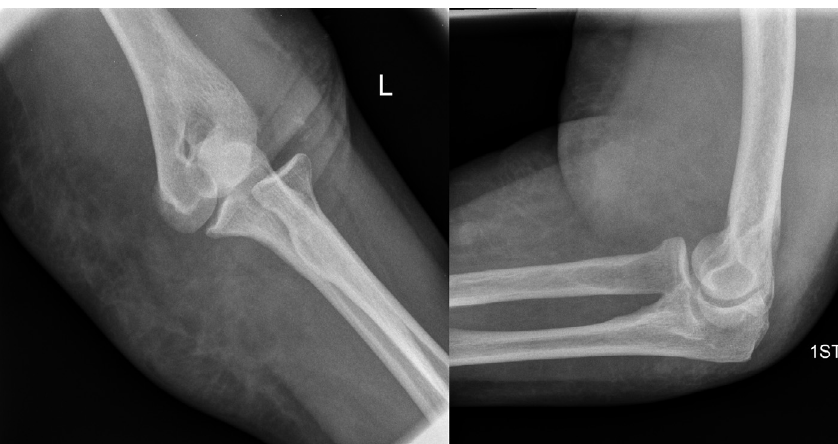
Figure 2. Elbow AP and lateral radiographs following closed